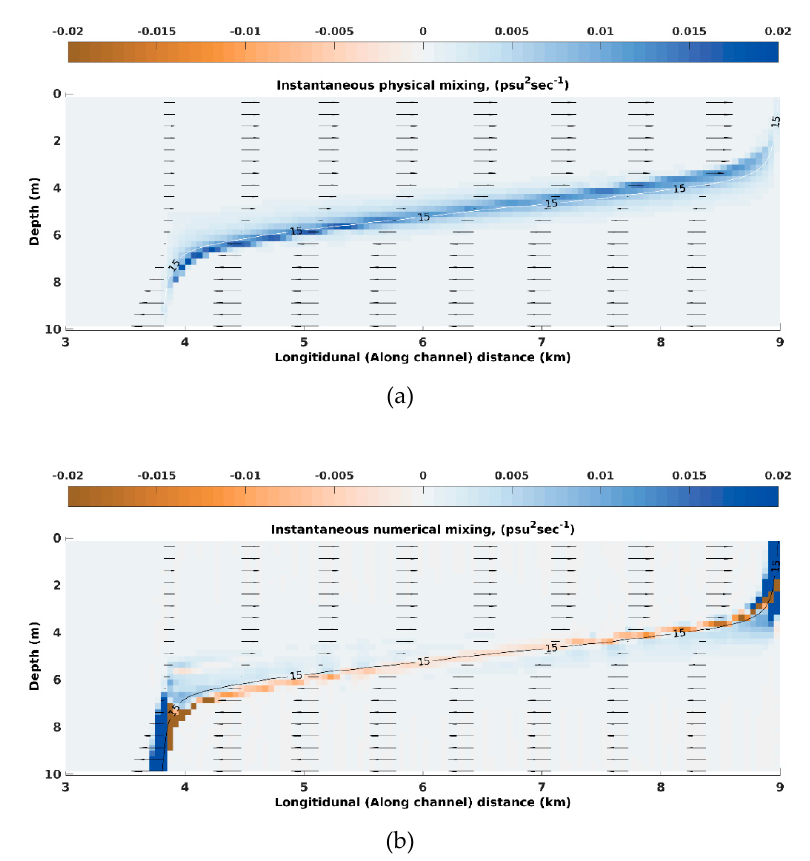
Figure 4. Test Case 3: Lock exchange using the MPDATA scheme with a ∆𝑥 of 50 m; Spatial distribution of ( a ) Physical mixing, ( b ) Numerical mixing at the end of simulation (2.2 h) drawn along with 15 psu isohaline.